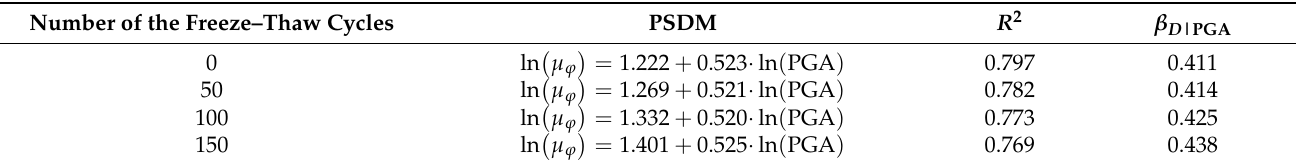
Table 3. PSDMs of the columns.